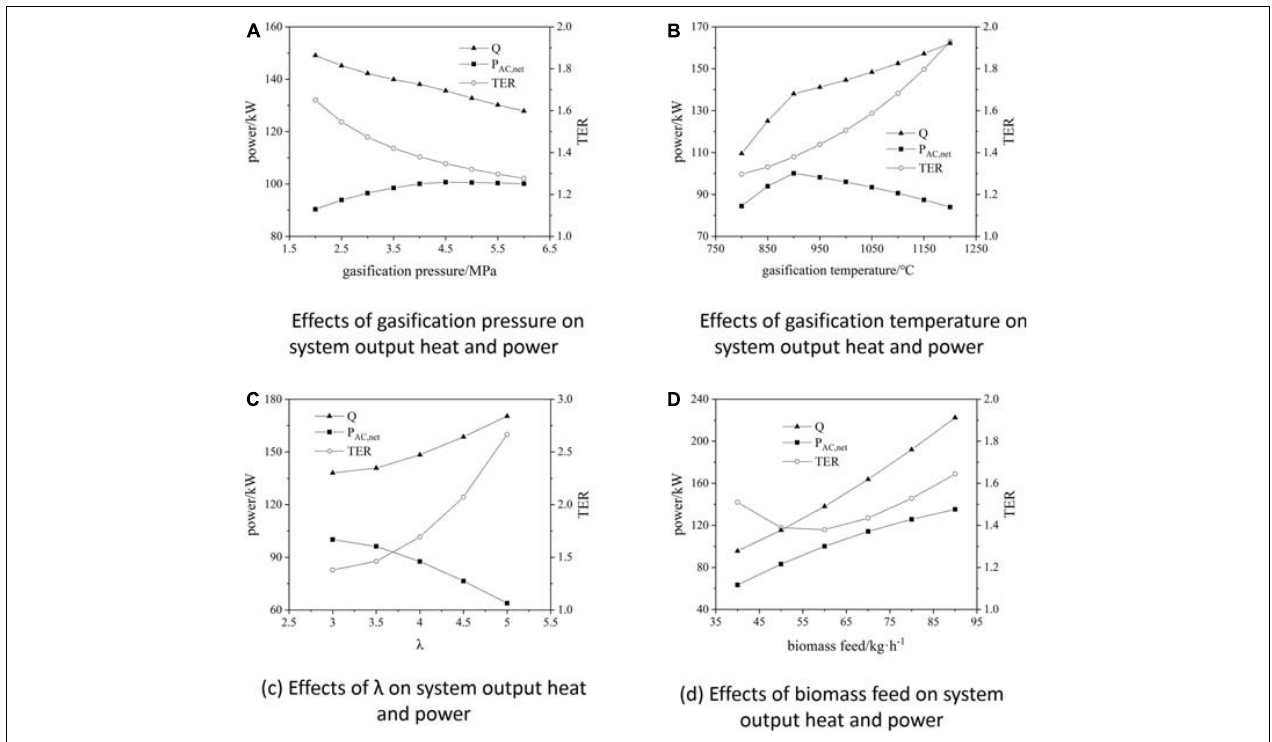
FIGURE 13 | Effect of input parameters on system output heat and power characteristics. (A) Effect of gasification pressure on system output heat and power. (B) Effect of gasification temperature on system output heat and power. (C) Effect of λ on the system output heat and power. (D) Effect of biomass feed on system output heat and